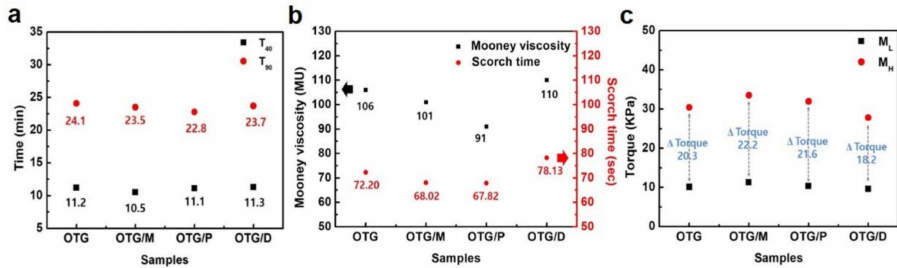
Figure 2. Curing properties of elastomer composites. ( a ) Curing properties of elastomer composites with hybrid oils. ( b ) Mooney viscosity of the elastomer composites with hybrid oils. ( c ) Torque of elastomer composites with hybrid